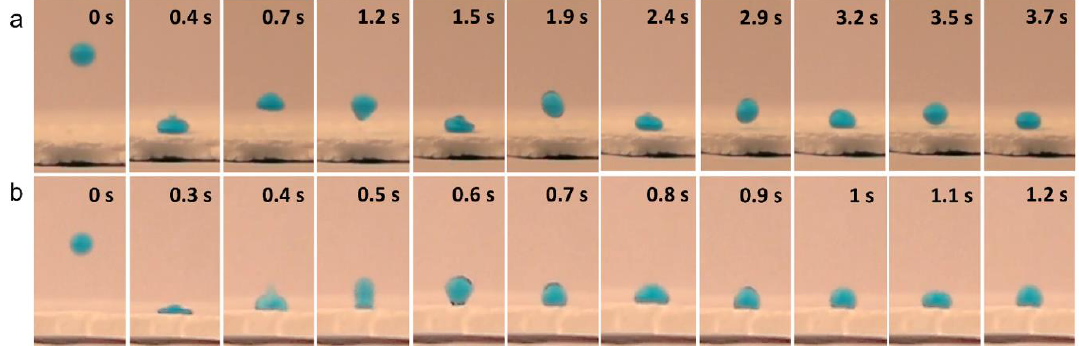
Figure 3. Photographs of an 8 μL water droplet (coloured with methylene blue) which were dropped from a height of 20 mm (tip to surface) and left to bounce on PE surfaces cured at 110 °C, using ( a ) hexane and ( b ) toluene as a dispersing solvent.